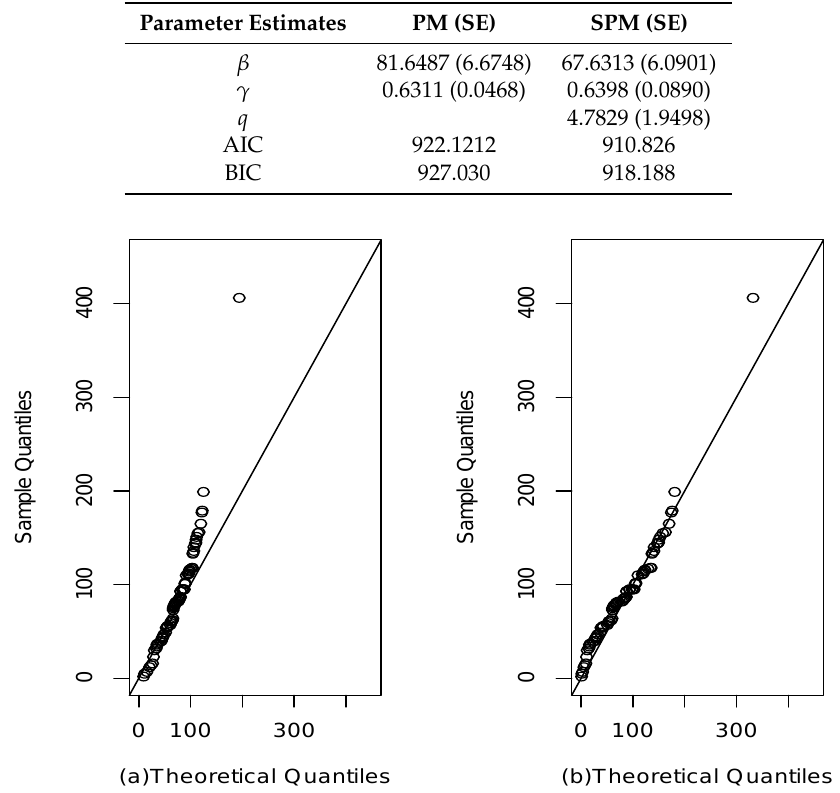
Figure 4. qqplots for rubidium dataset: ( a ) PM model; ( b ) SPM